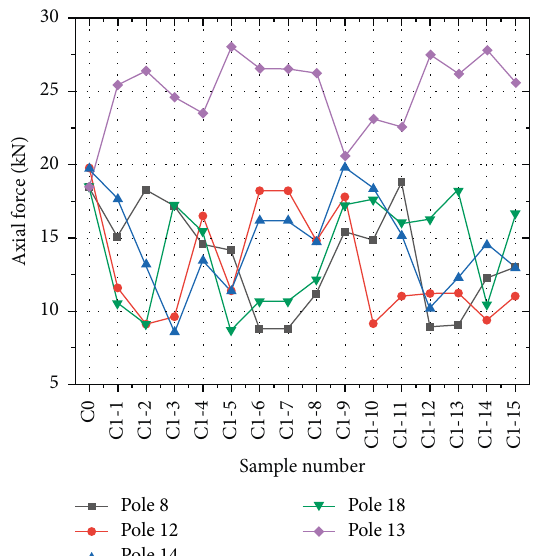
Figure 10: Axial force value of the pole in the gap interval [0-0.7].